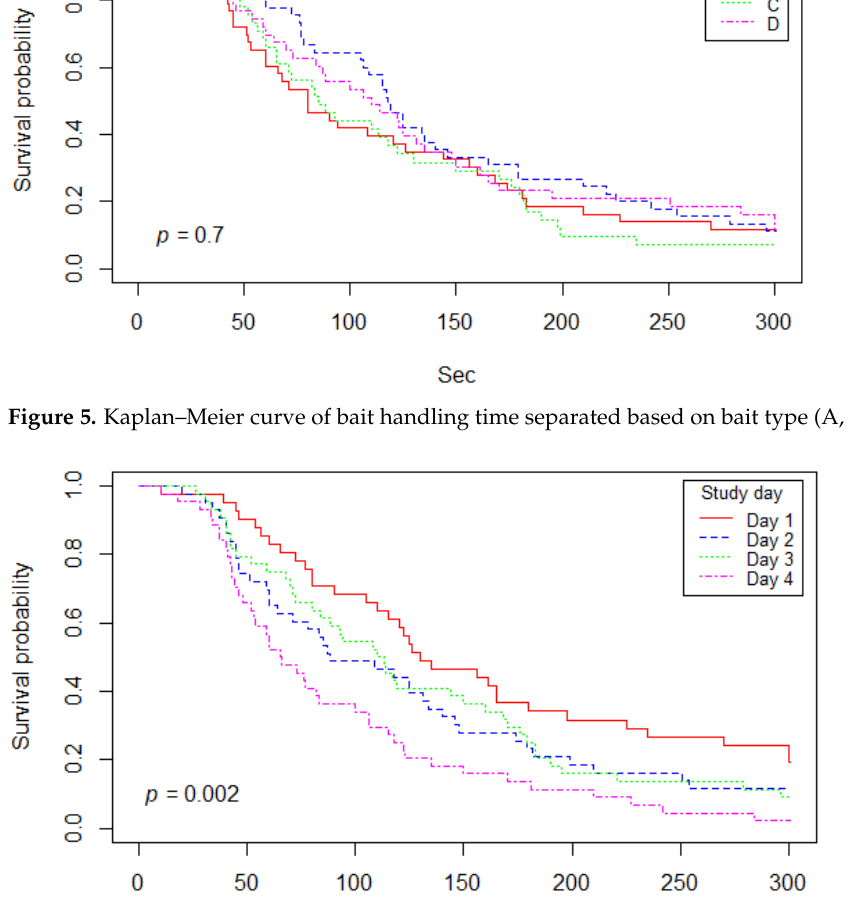
Table 6. The final mixed effects Cox model indicating factors associated with time until first con- tact with the bait and bait handling time in dogs.